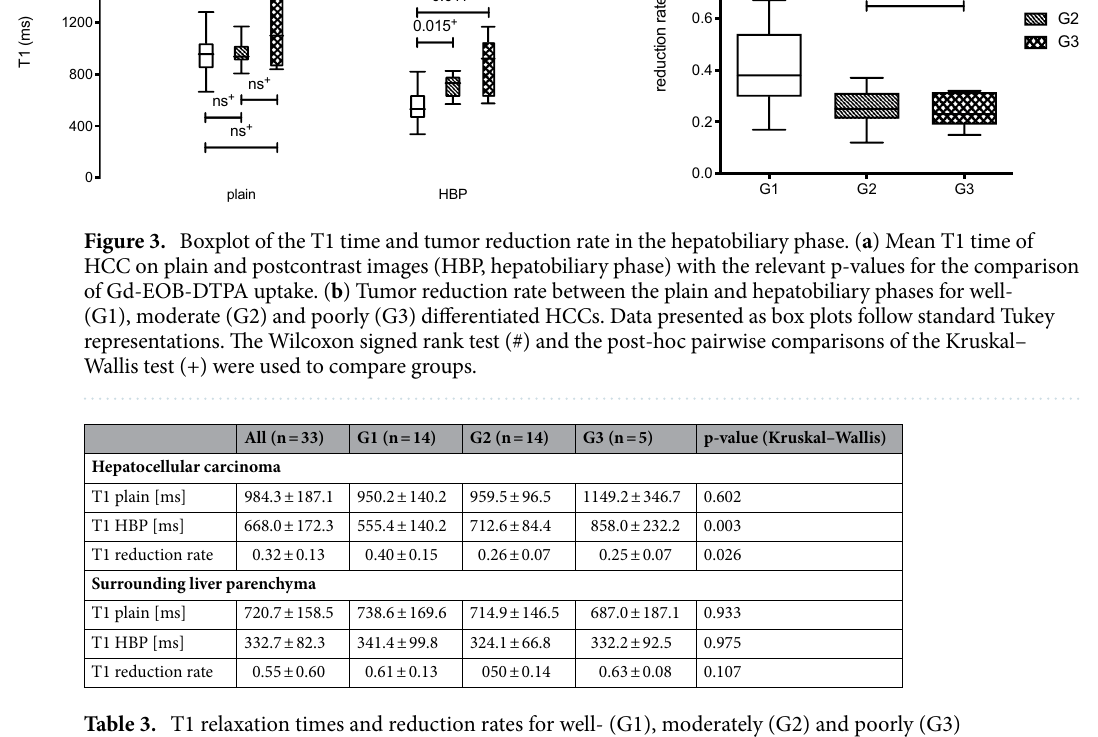
Table 3. T1 relaxation times and reduction rates for well- (G1), moderately (G2) and poorly (G3) differentiated HCCs and their surrounding liver parenchyma. The values indicate the mean ± standard deviation.